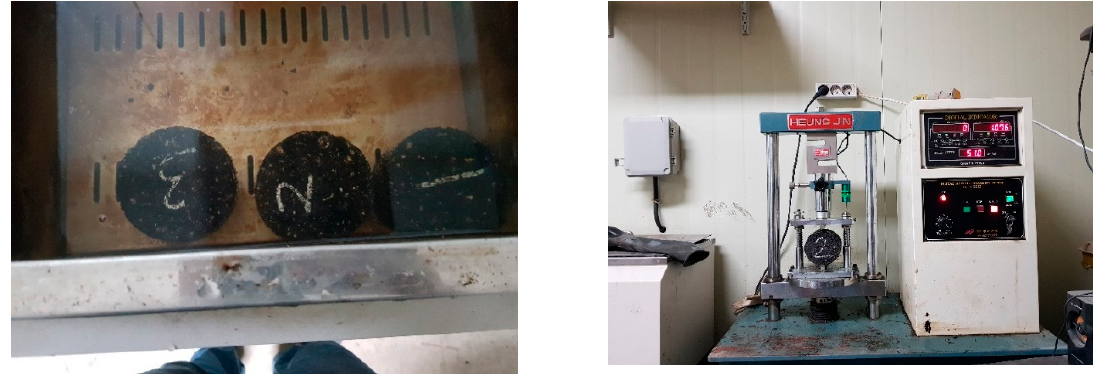
Figure 2. Tensile strength ratio test .